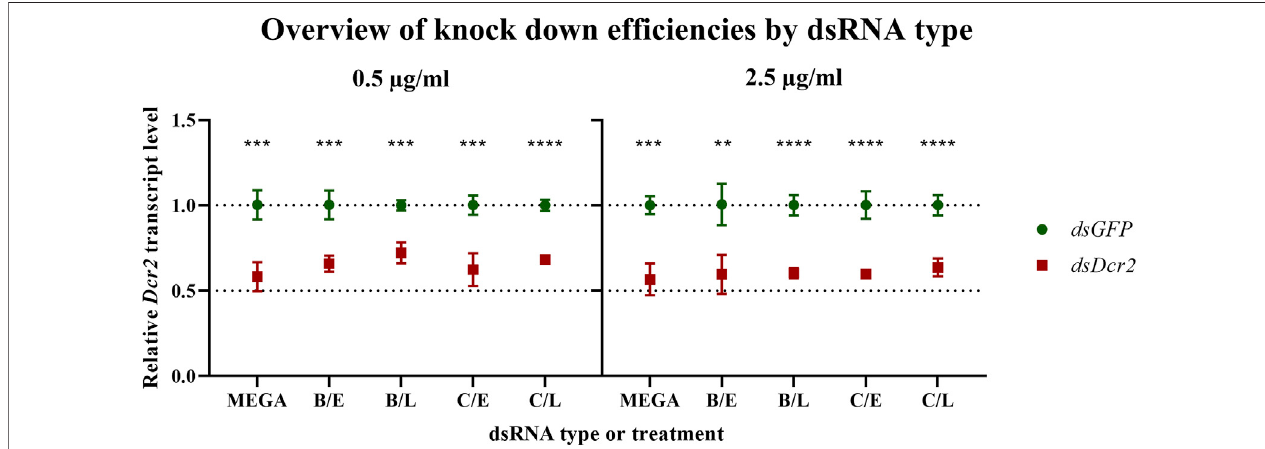
FIGURE 7 | Bacteria-derived dsRNA is effective at inducing a knockdown in the RP- Hz GUT-AW1 cell line. Bacteria-derived or MEGAscript produced dsRNA targeting GFP or the Helicoverpa Dicer2 gene was transfected into these gut-derived cells of Helicoverpa zea . Transcript levels were assessed 1 day after treatment. Symbols indicate the mean, error bars the standard deviation. Four replicates were tested per condition. All experimental treatments yielded signi fi cant knockdowns as assessedthroughmultipleunpairedparametric t -test(** p ≤ 0.01;*** p ≤ 0.001;**** p ≤ 0.0001).MEGA=dsRNAproduced invitro byusingtheMEGAscriptkit;B= sonication pre-treatment; C = heating pre-treatment; E = NaCl digested dsRNA; L = LiCl precipitated